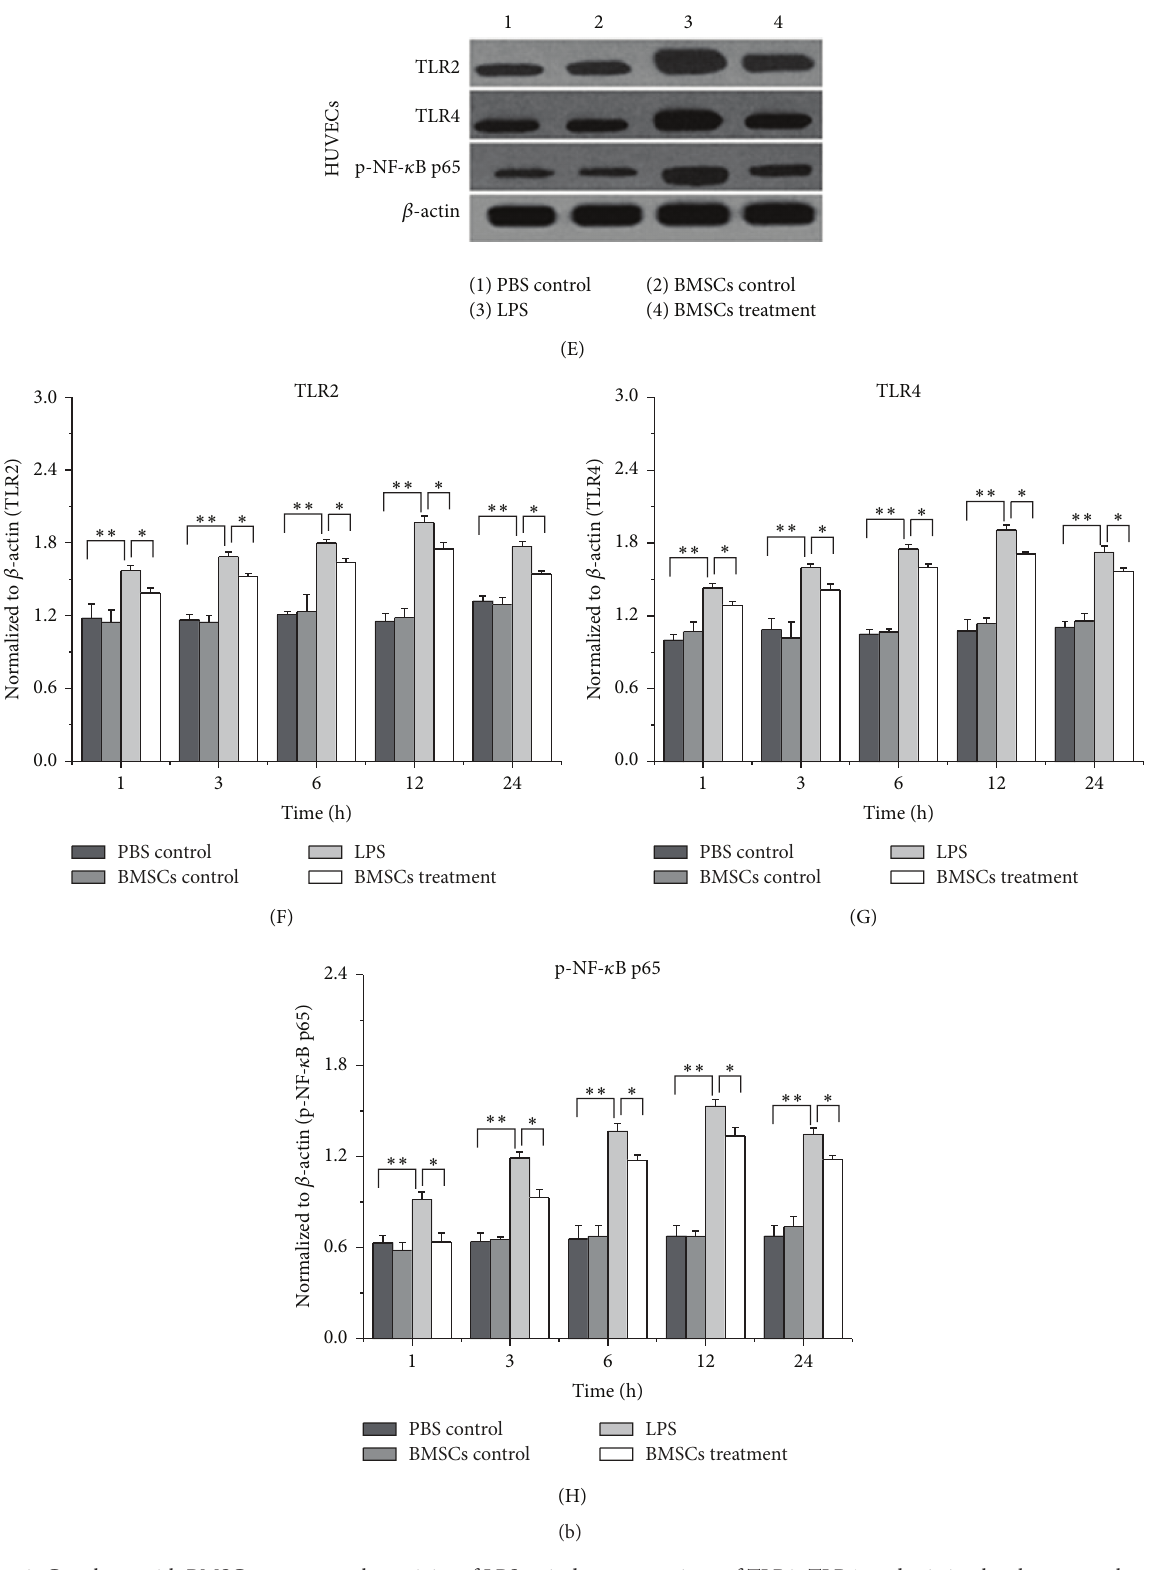
Figure 2: Coculture with BMSCs attenuates the activity of LPS to induce expressions of TLR2, TLR4, and p65 in alveolar macrophages (a) and HUVECs (b) at the protein level. The total proteins were extracted from the cultured alveolar macrophages and HUVECs treated (1) PBS control, (2) BMSCs, (3) LPS, and (4) BMSCs and LPS. The expressions of TLR2, TLR4, and p-NF- 𝜅 B p65 were determined by Western blot. The density of specific bands was quantitated. Data are expressed as the mean ± SD from three experiments. ∗ 𝑃 < 0.05 , ∗∗ 𝑃 < 0.01